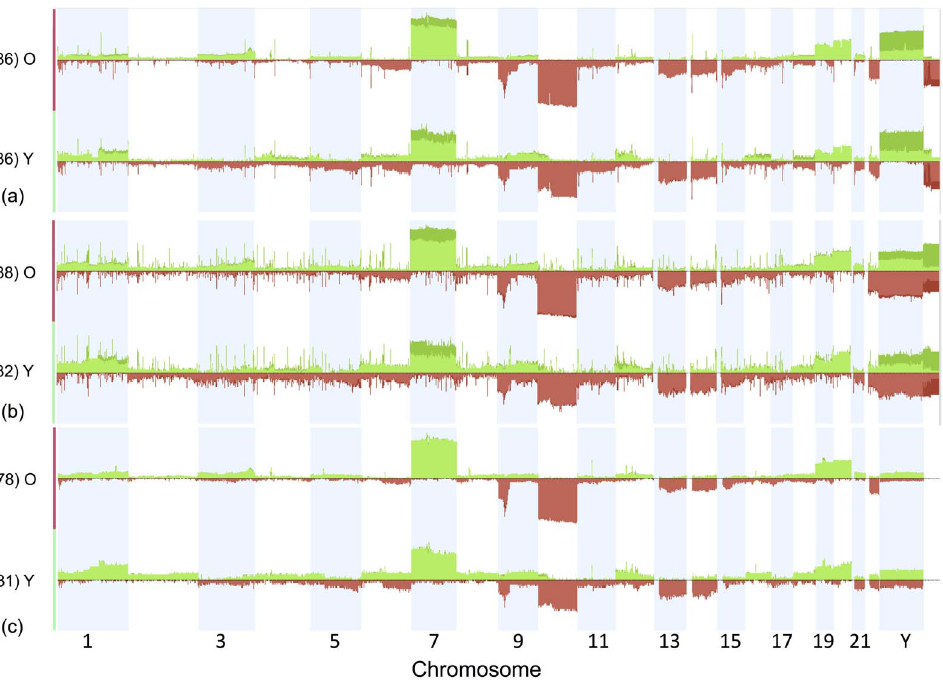
Figure 3. Genome-wide copy number alteration profiles of old and young GBM samples. Data are from (a) Agilent Human Genome CGH Microarray 244A (Memorial Sloan-Kettering Cancer Center), (b) Affymetrix Genome-Wide Human SNP Array 6.0 (Broad Institute of MIT and Harvard), (c) Illumina 550 K Infinium HumanHap550 SNP Chip (HudsonAlpha Institute for Biotechnology) platforms (chr 1–23). Green bars represent amplification and red bars represent deletion. The height of each bar represents the frequency of the alteration in the group. The differentially